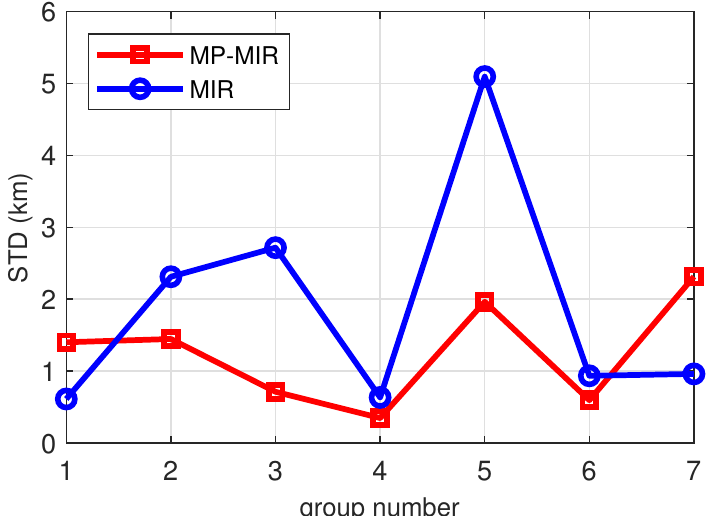
Figure 10. STD statistical results for each group of 12